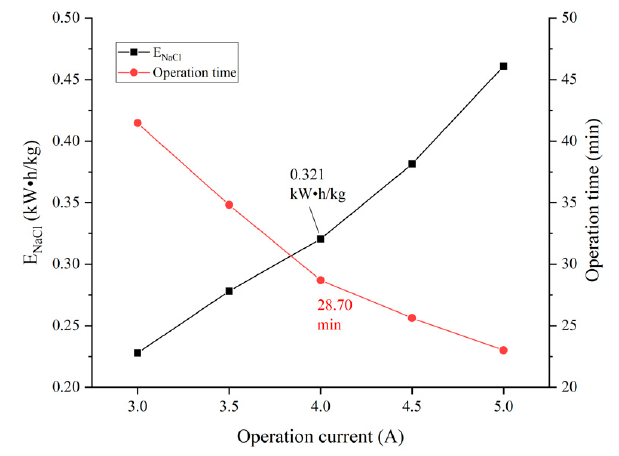
Figure 8. Influence of current on operating state of the device.